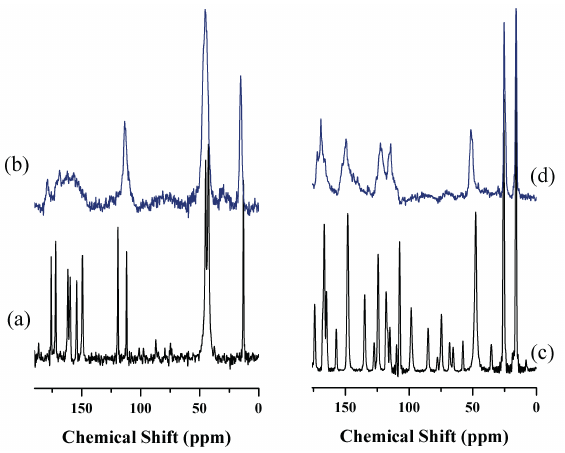
Figure 5: 13 C CP MAS NMR Spectra of (a) sodium pipemidic salt, (b) LDH-CO -PIP, (c) sodium nalidixic salt and (d) LDH-CO 3